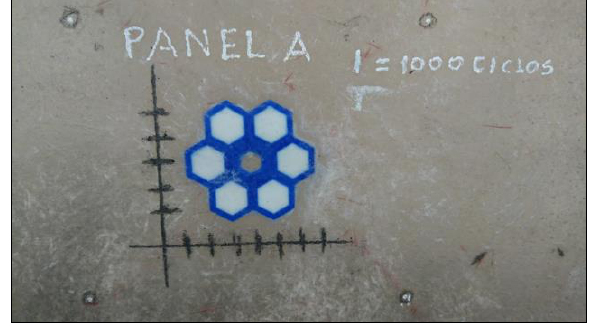
Figure 17. Modified panel K impacted at 1 × 10 3 cycles with 343 kN/m 2 slamming pressure.